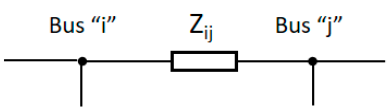
Figure 3. Two system buses linked by a power line.